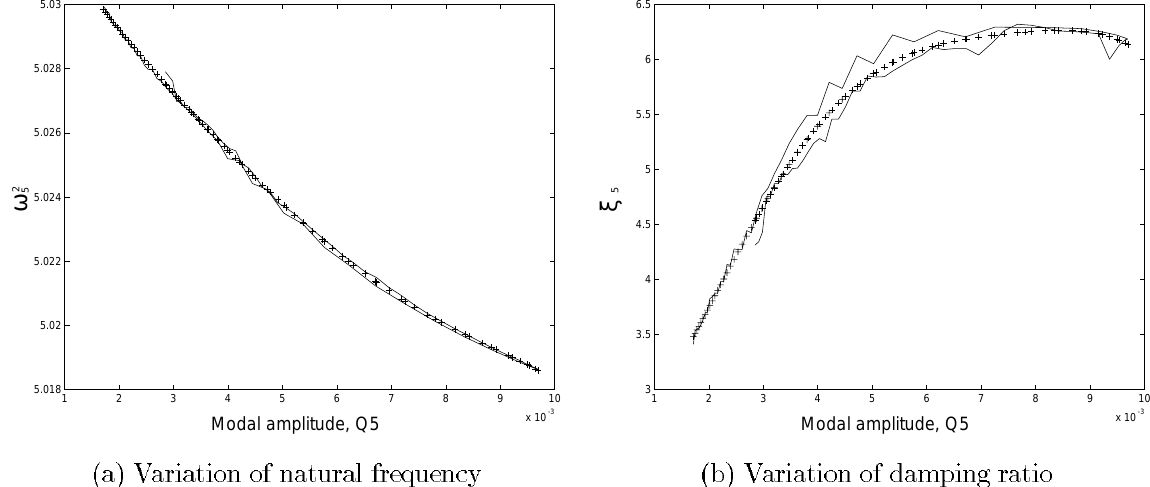
Fig. 14. Variation of non-linear modal parameters: ∗ ∗ ∗ ∗ ∗ Extracted values, Curve-fitted values.